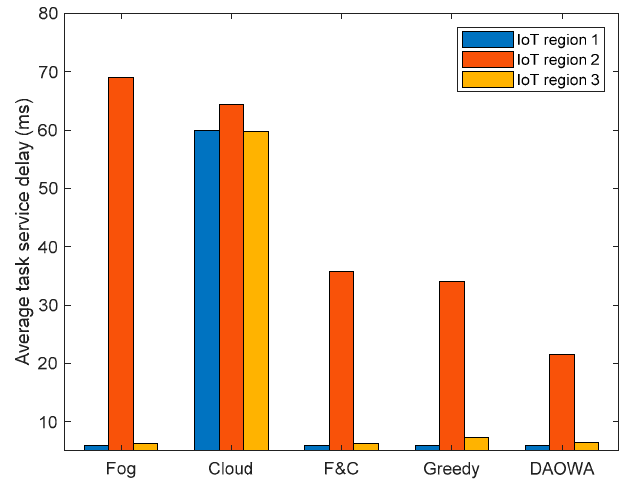
Figure 4. Average task service delay for each of the three IoT regions computed with the different algorithms.